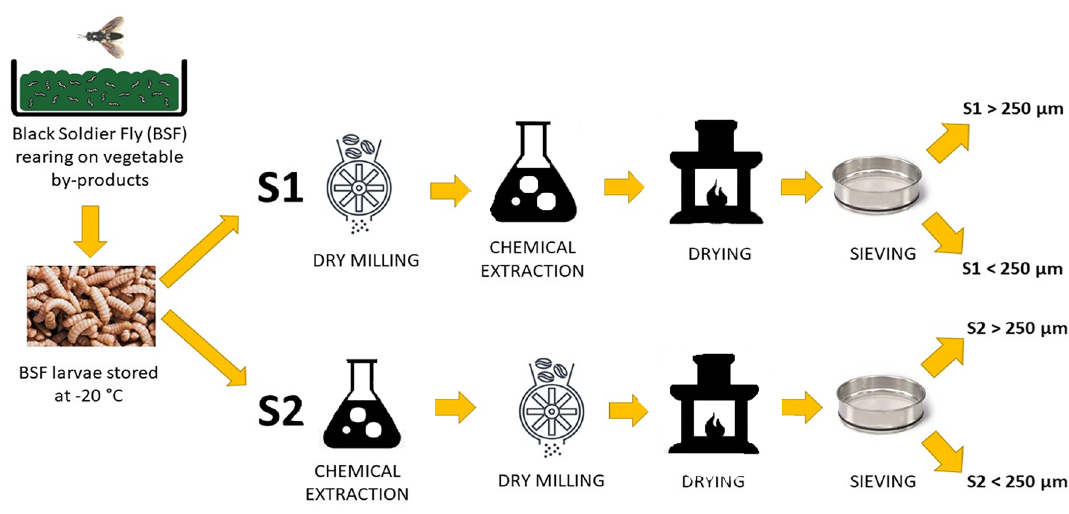
Figure 1. Methods for obtaining nitrogen-rich